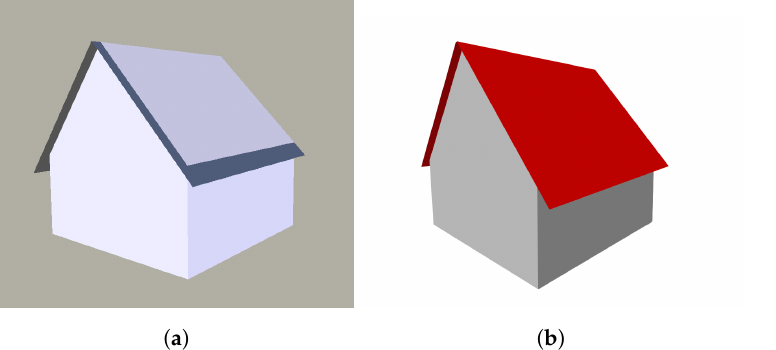
Figure 12. 3D building reconstruction: ( a ) simplified model with roof overhang; ( b ) semantic